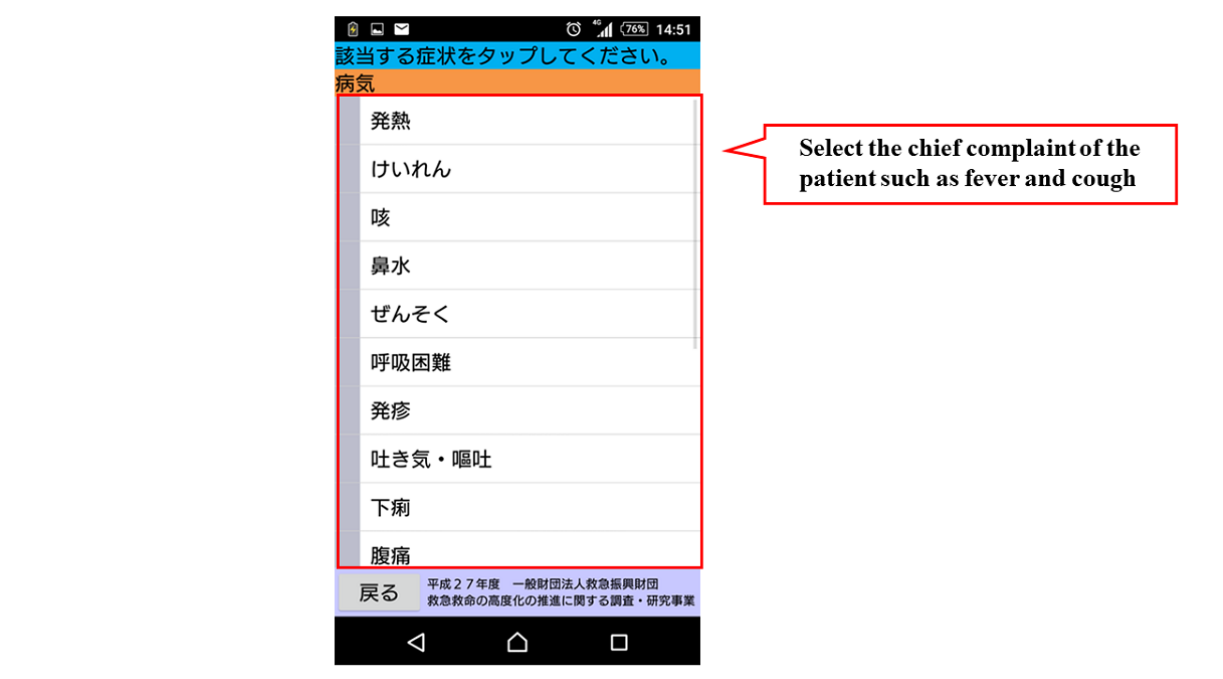
Figure 4. Screenshot of chief complaint selection.